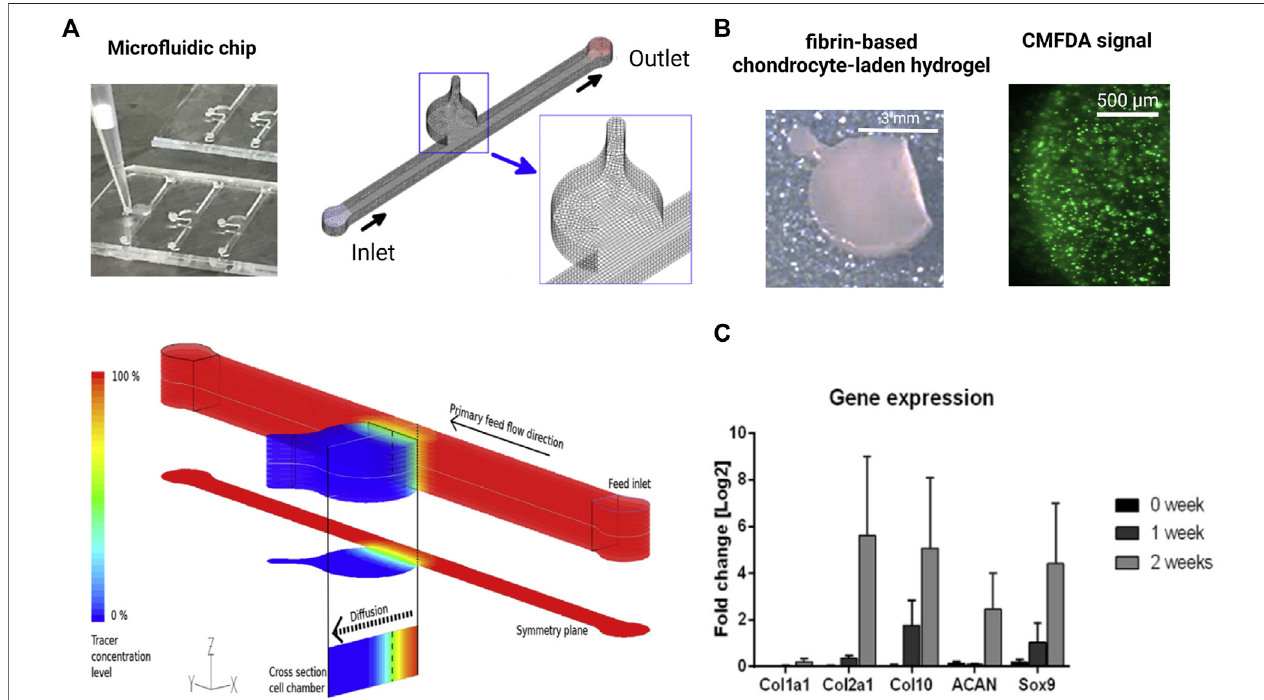
FIGURE 5 | Biochip technologies for native tissue-like molecular gradients. (A) Macroscopic cartilage-on-a-chip system presenting native-like tissue-like molecule diffusion dynamics analyzed by fl uid dynamic simulations. (B) Steep nutrient and metabolite gradients do not alter the high chondrocyte viability of chondrocytes (green fl uorescent CMFDAassay) and showed (C) cartilage-speci fi cmolecular expression levels ofmatrixand chondrocyte-related genesanalyzed byRT-qPCR over2 weeks of cultivation. Reproduced with permissions from (Rosser et al., 2019).